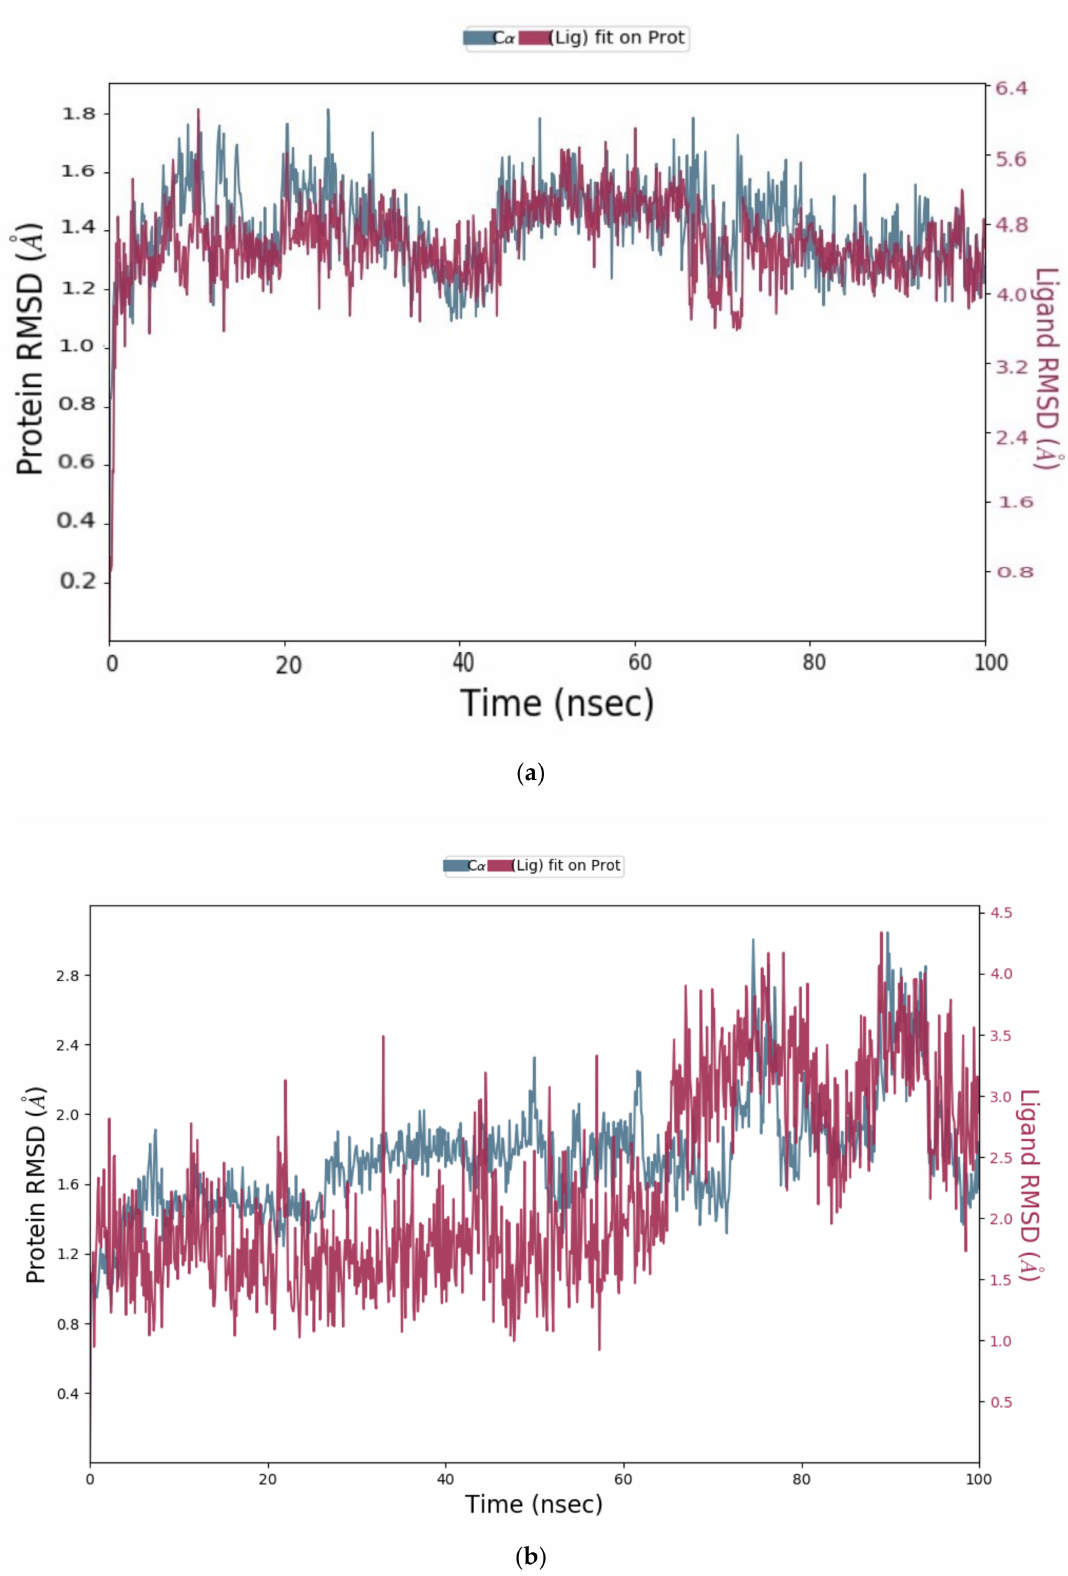
Figure 11. RMSD graph of ( a ) Cathepsin B-DTBN; ( b ) Cathepsin B-iDTBN covalent